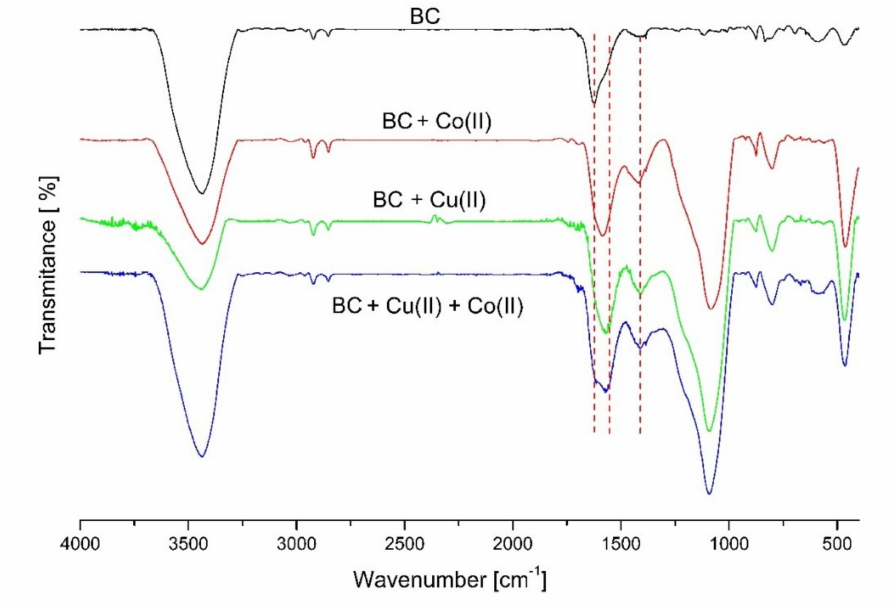
Figure 1. FT-IR spectra of investigated pure wheat straw biochar, biochar spiked with Co (II) salt, biochar spiked with Cu (II) salt, and biochar spiked with a mix of Co (II) and Cu (II) salts.